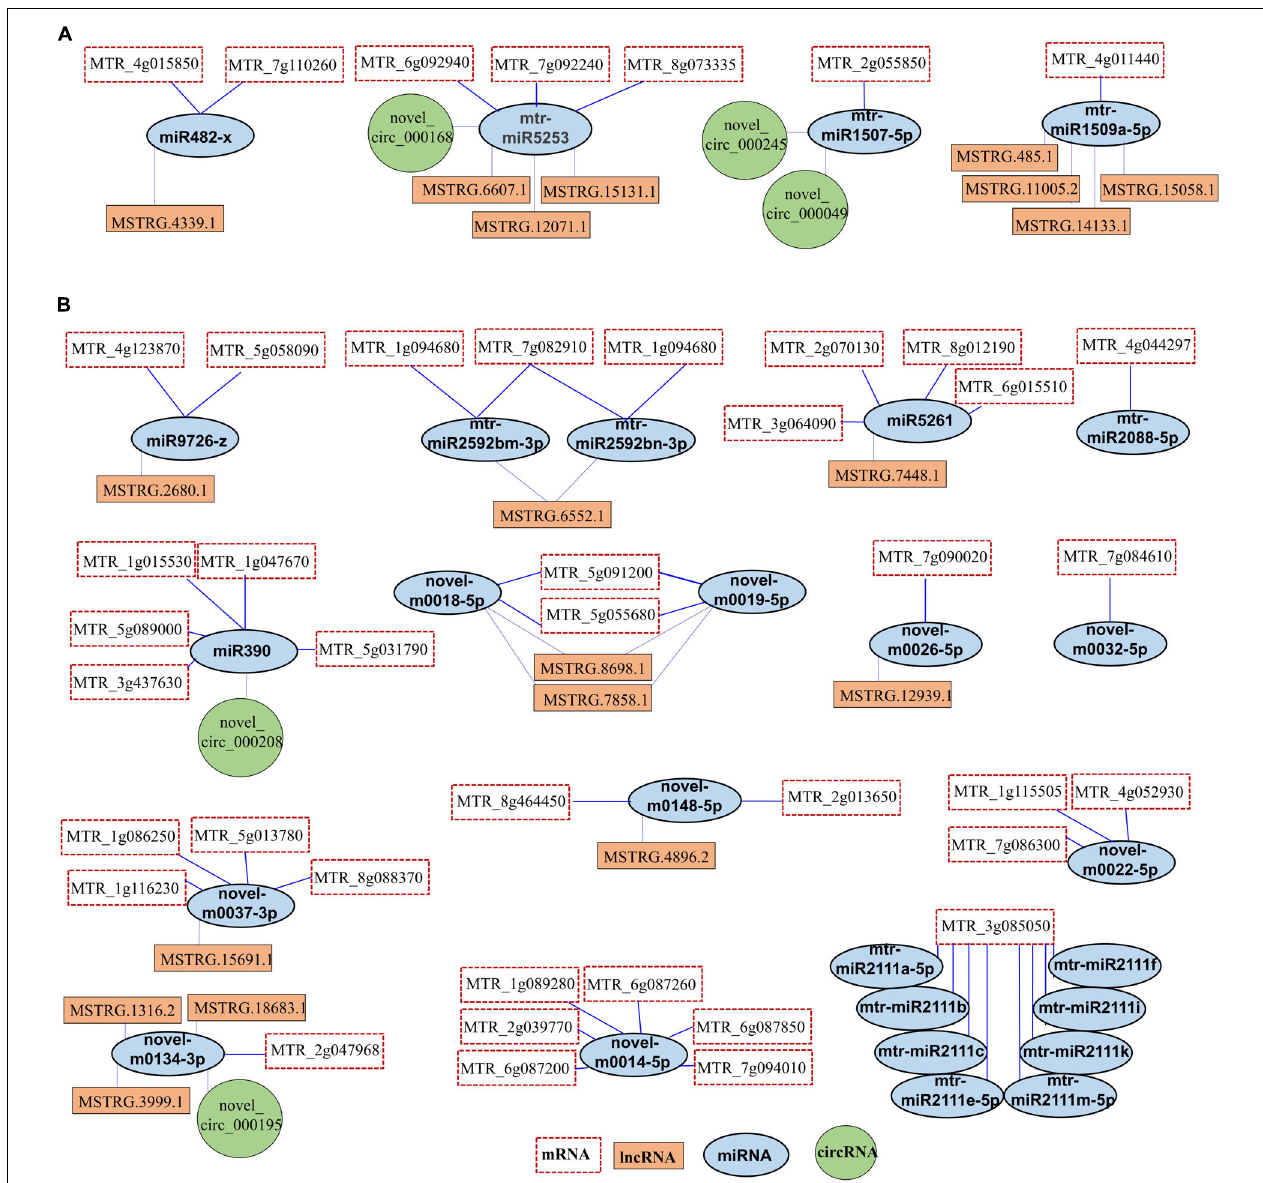
FIGURE 9 | The ceRNA networks. (A) The ceRNA networks were constructed with up-regulated miRNAs. (B) The ceRNA networks were constructed with down-regulated